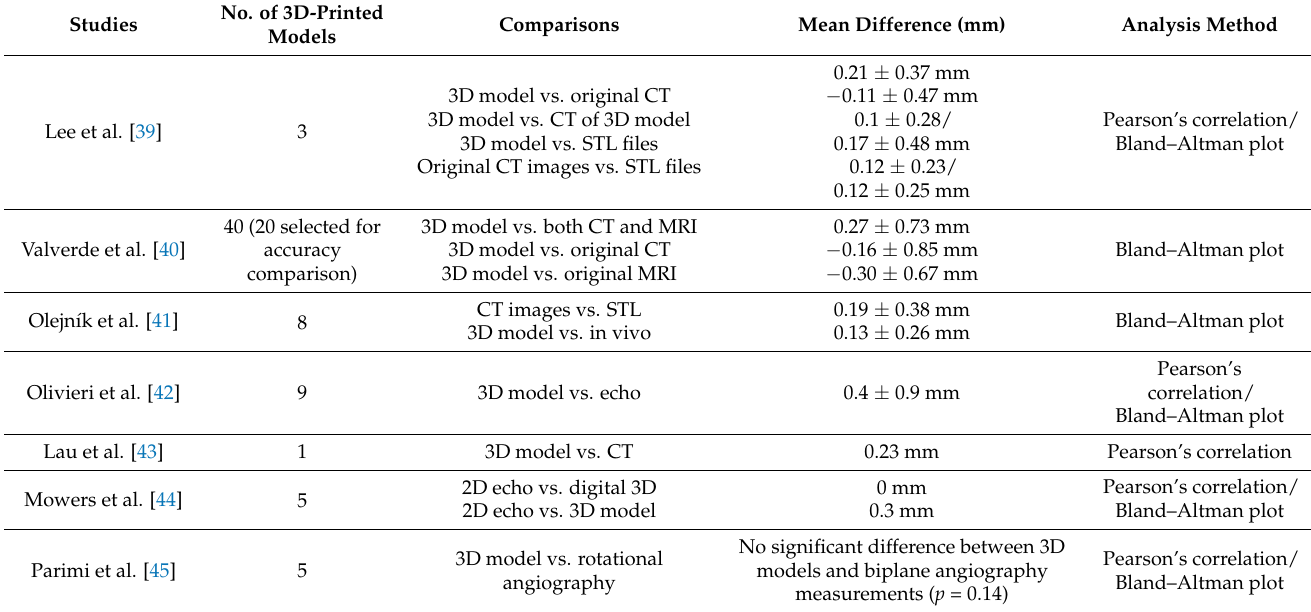
Table 1. Accuracy of 3D-printed heart model in comparison with original source images according to the current literature. Modified from Lee et al.